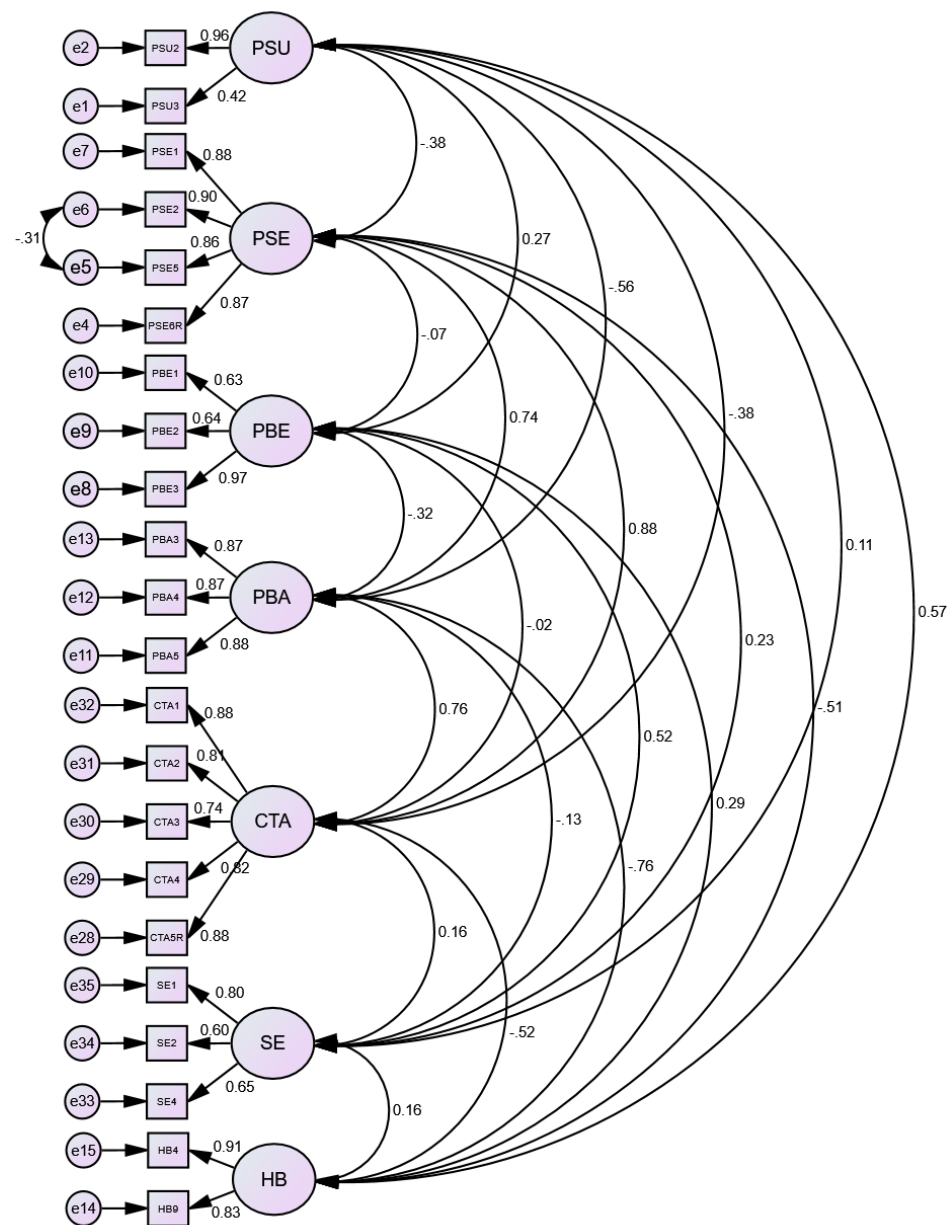
Figure 1. CFA of HBM measurement